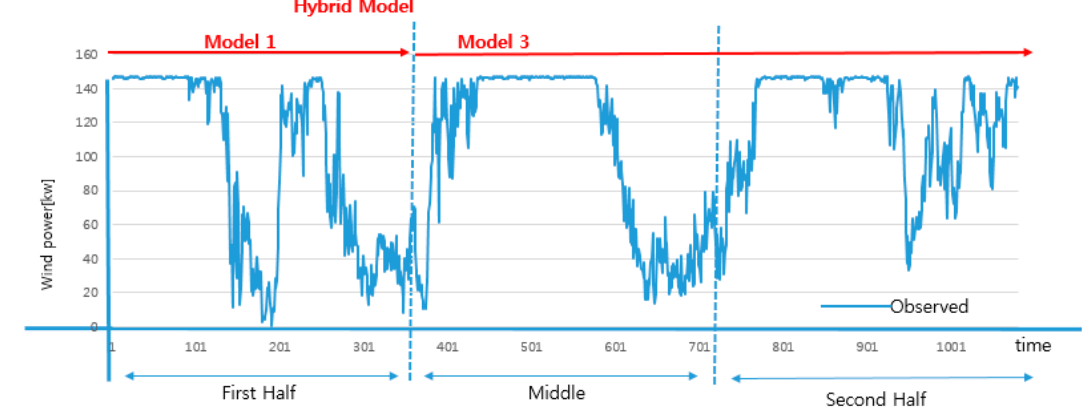
Figure 10. Wind power prediction by using the hybrid model.